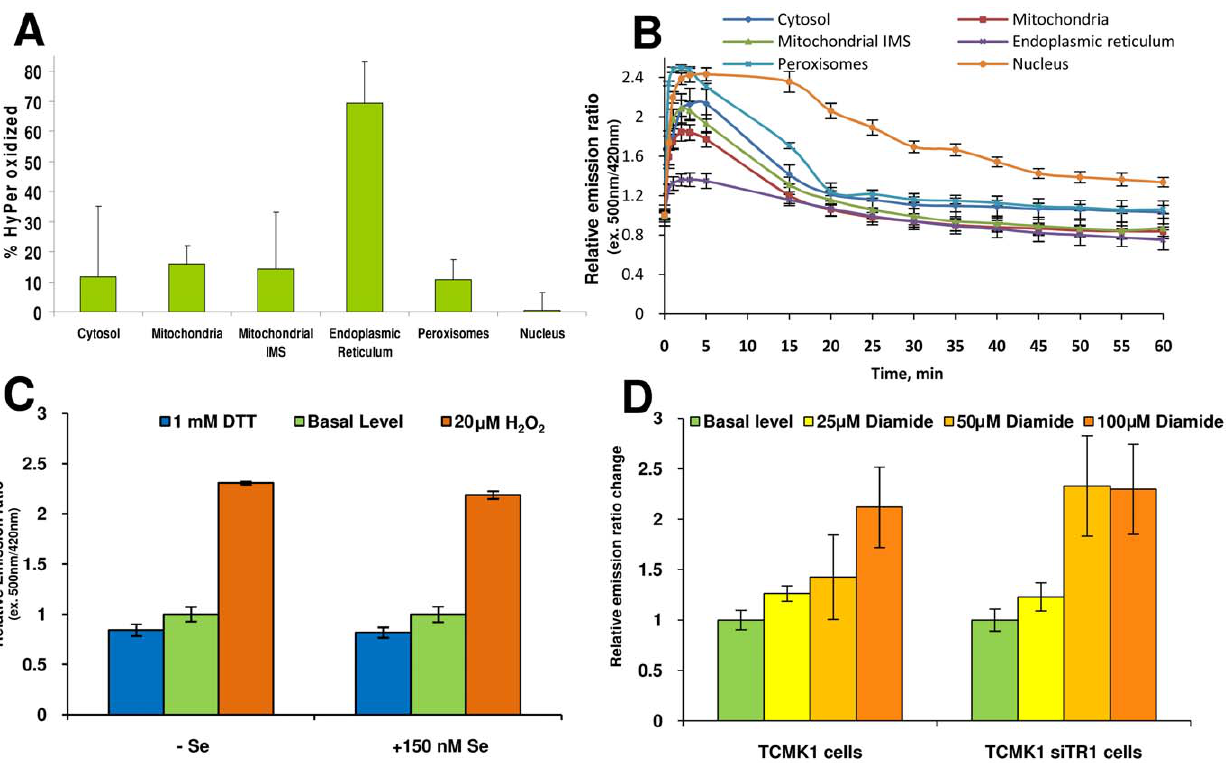
Figure 3. Redox state of HyPer targeted to different intracellular compartments. (A) Percentage of oxidized HyPer in cellular compartments. To estimate percentage of oxidized HyPer, we recorded fluorescence from HEK 293 cells stably expressing HyPer obtained under basal, reducing (30 min, 1 mM DTT), and oxidizing (3 min, 50 m M H 2 O 2 ) conditions. (B) Dynamics of intracellular response of HEK 293 cells to 5 m M H 2 O 2 . (C) Redox state of HyPer under conditions that lead to the reduced expression of selenoproteins in HEK 293 cells. (D) TR1 knockdown TCMK cells treated with diamide. TR1 knockdown and control TCMK cells stably expressing HyPer in cytosol were treated for 30 min with indicated concentrations of diamide. Data represent mean of 3 measurements, 6 standard deviation.